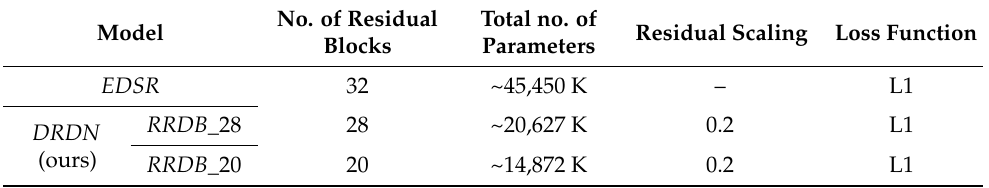
Table 1. Parameters of EDSR and proposed